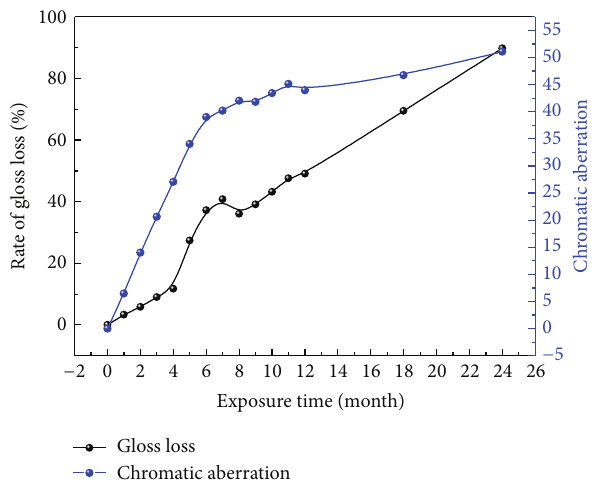
Figure 2: Change of rate of gloss loss and chromatic aberration of PS with extended exposure in the environment of Xisha Islands.